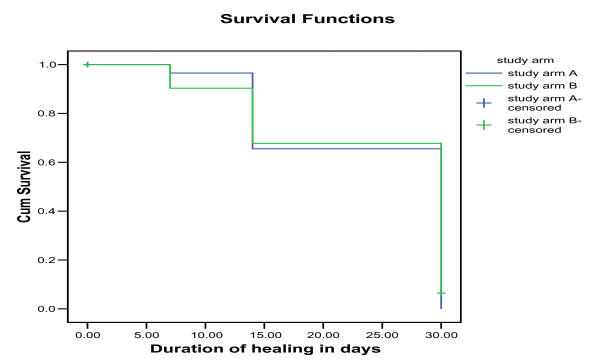
Survival Function.